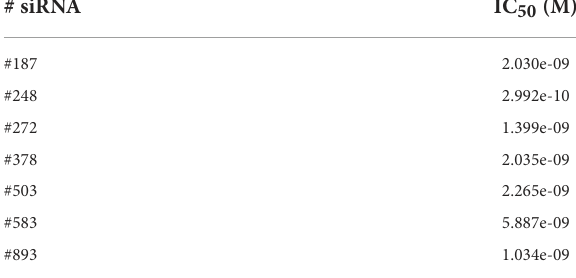
TABLE 2 IC 50 of tested siRNAs on mNOX3 activity. #